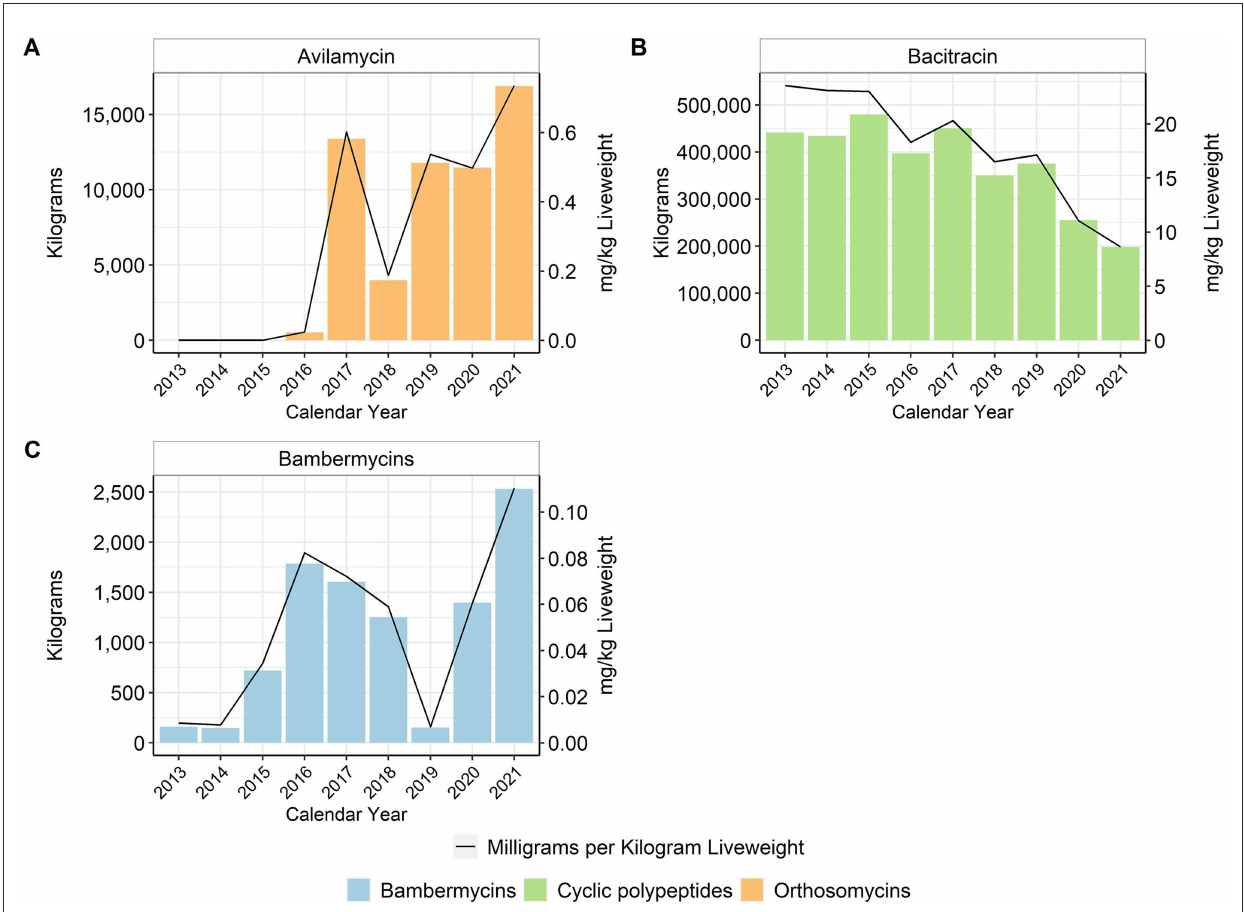
FIGURE5 Not Medically Important antimicrobials avilamycin (A) , bacitracin (B) , and bambermycins (C) used in broiler feed, 2013–2021. Total kilograms are shown by the bars (left Y-axis) and total mg/kg liveweight are shown by the line (right